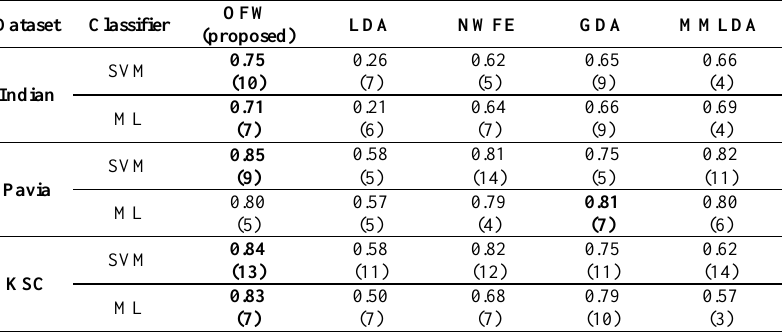
Table 4. Highest classification accuracies achieved by 16 training samples (numbers in parentheses represent the number of features which obtain the highest average accuracies in experiments).